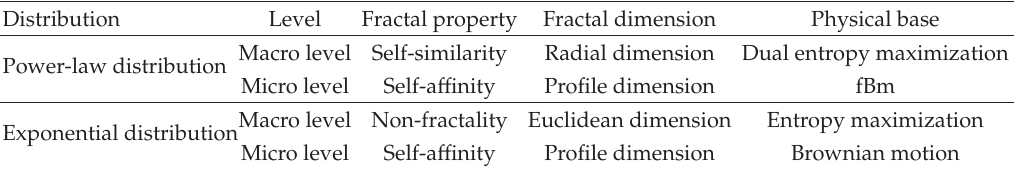
Table 5: The similarities and di ff erences between inverse power law and negative exponential dis-